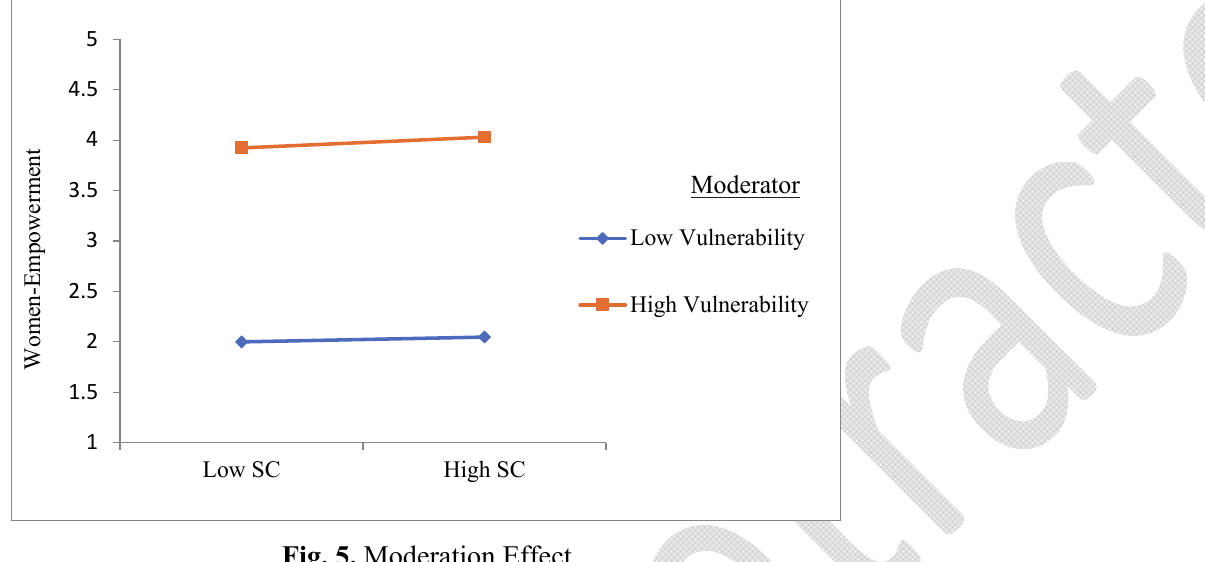
Fig. 5. Moderation